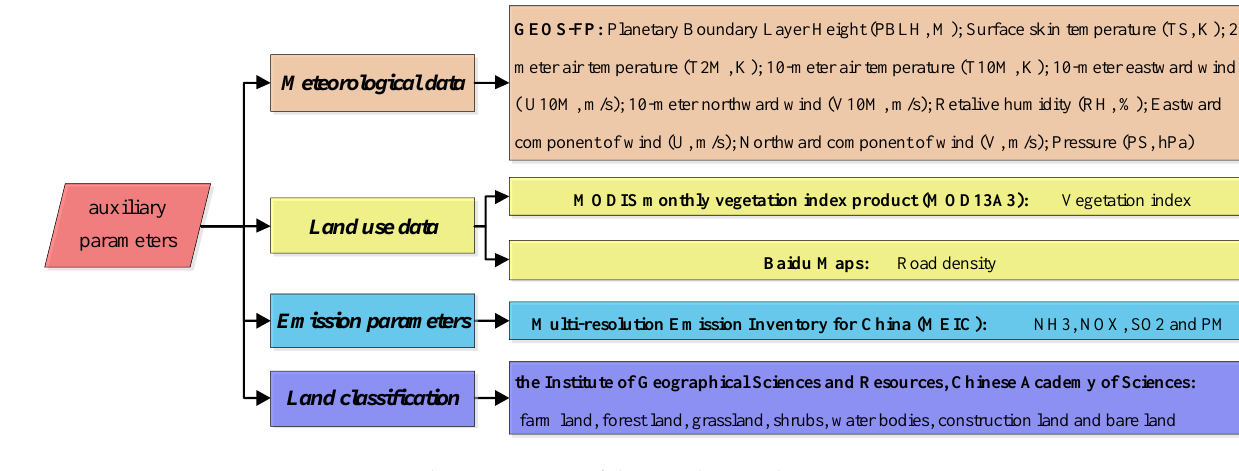
Figure 2. The prescription of the supplemental parameters.